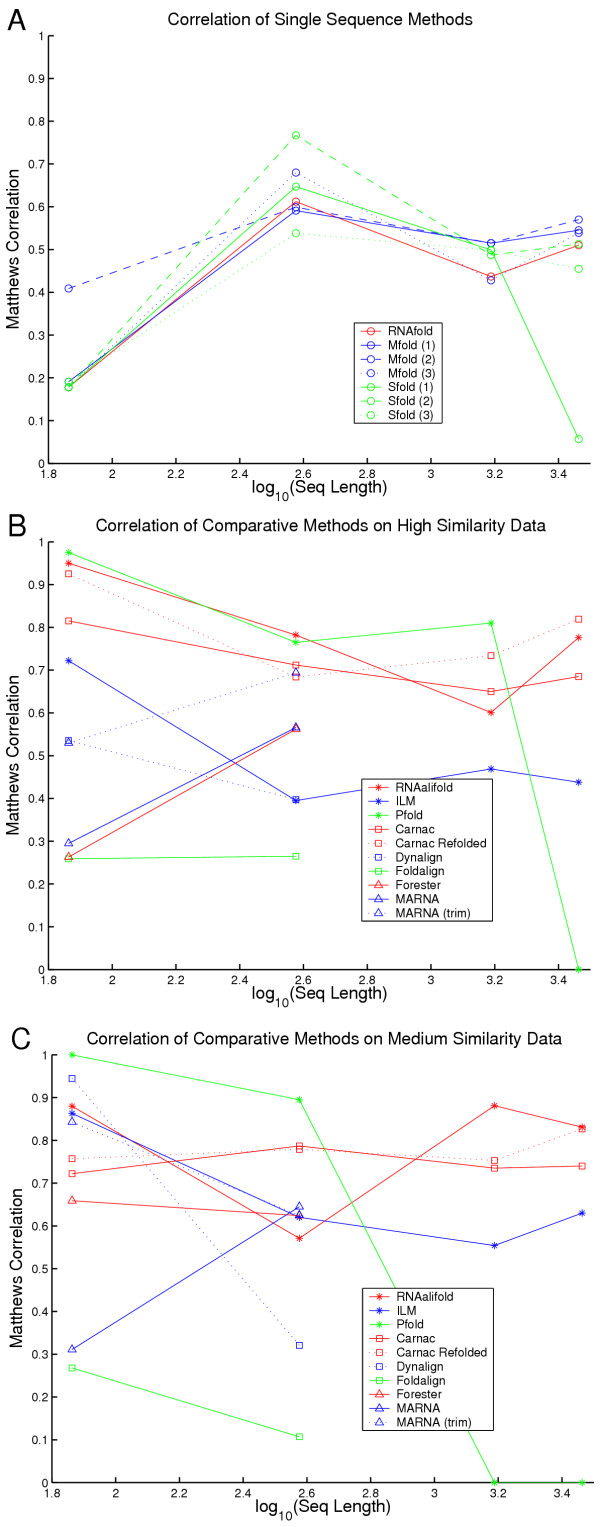
Prediction correlation with reality. Matthews correlation coefficient versus the logarithm of the sequence length for a range of different ncRNAs and structure prediction algorithms. Inset A shows accuracies of thermodynamic single sequence prediction algorithms. Insets B and C shows accuracies of comparative methods on the high and medium similarity data-sets respectively.